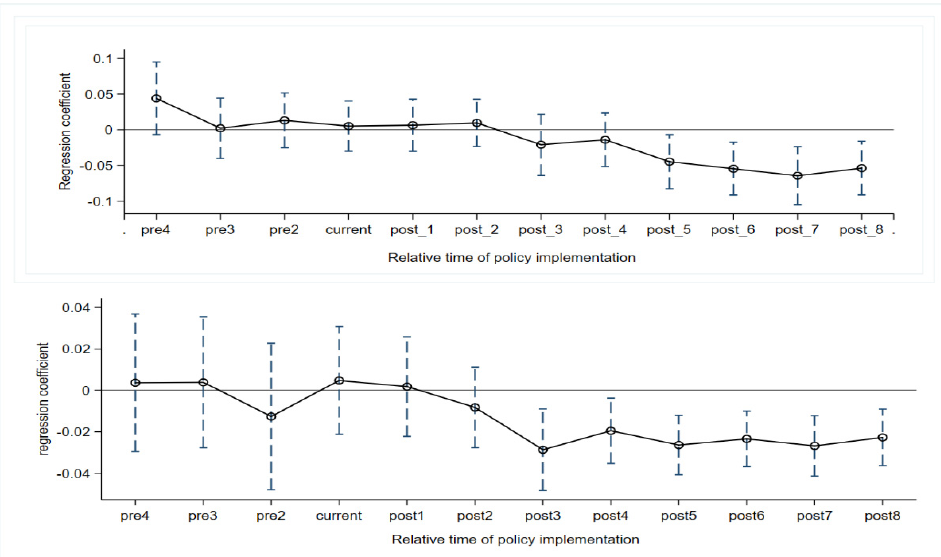
Figure 4. Dynamic evolution of the convergence effect of the pilot policy.